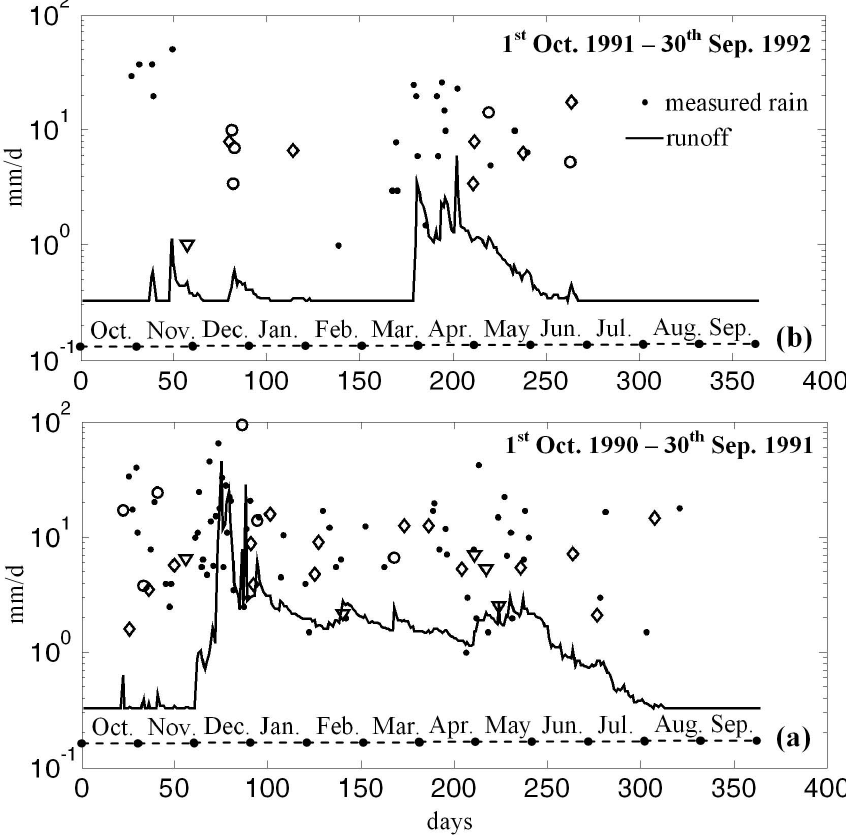
Fig. 12. Observed (dots) and simulated (empty circles, triangles and diamonds) daily rainfall intensities at the location of the hydroelectric plant (HP, point A in Fig. 2) for the period 1 October 1990–30 September 1992 (same period as in Fig. 1); see main text for details.